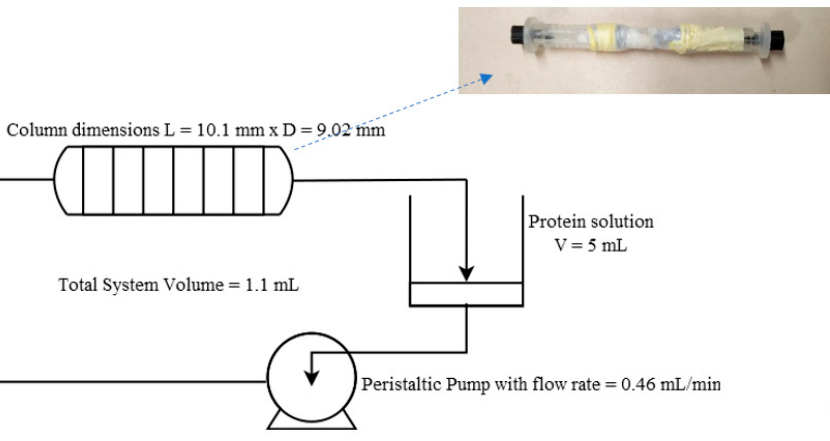
Figure 6. Schematic representation of process